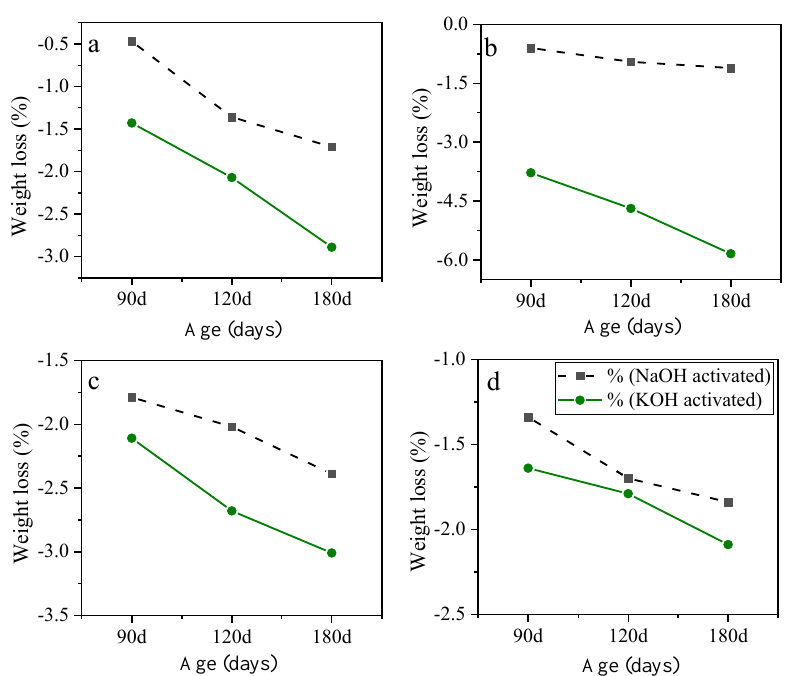
Figure 4. The weight loss of samples with ( a ) A/S = 0.4, molarity = 6 and NO/NS = 1, ( b ) A/S = 0.4, molarity = 6 and NO/NS = 3, ( c ) A/S = 0.6, molarity = 6, and NO/NS = 1, and ( d ) A/S = 0.4, molarity = 10 and NO/NS = 3.